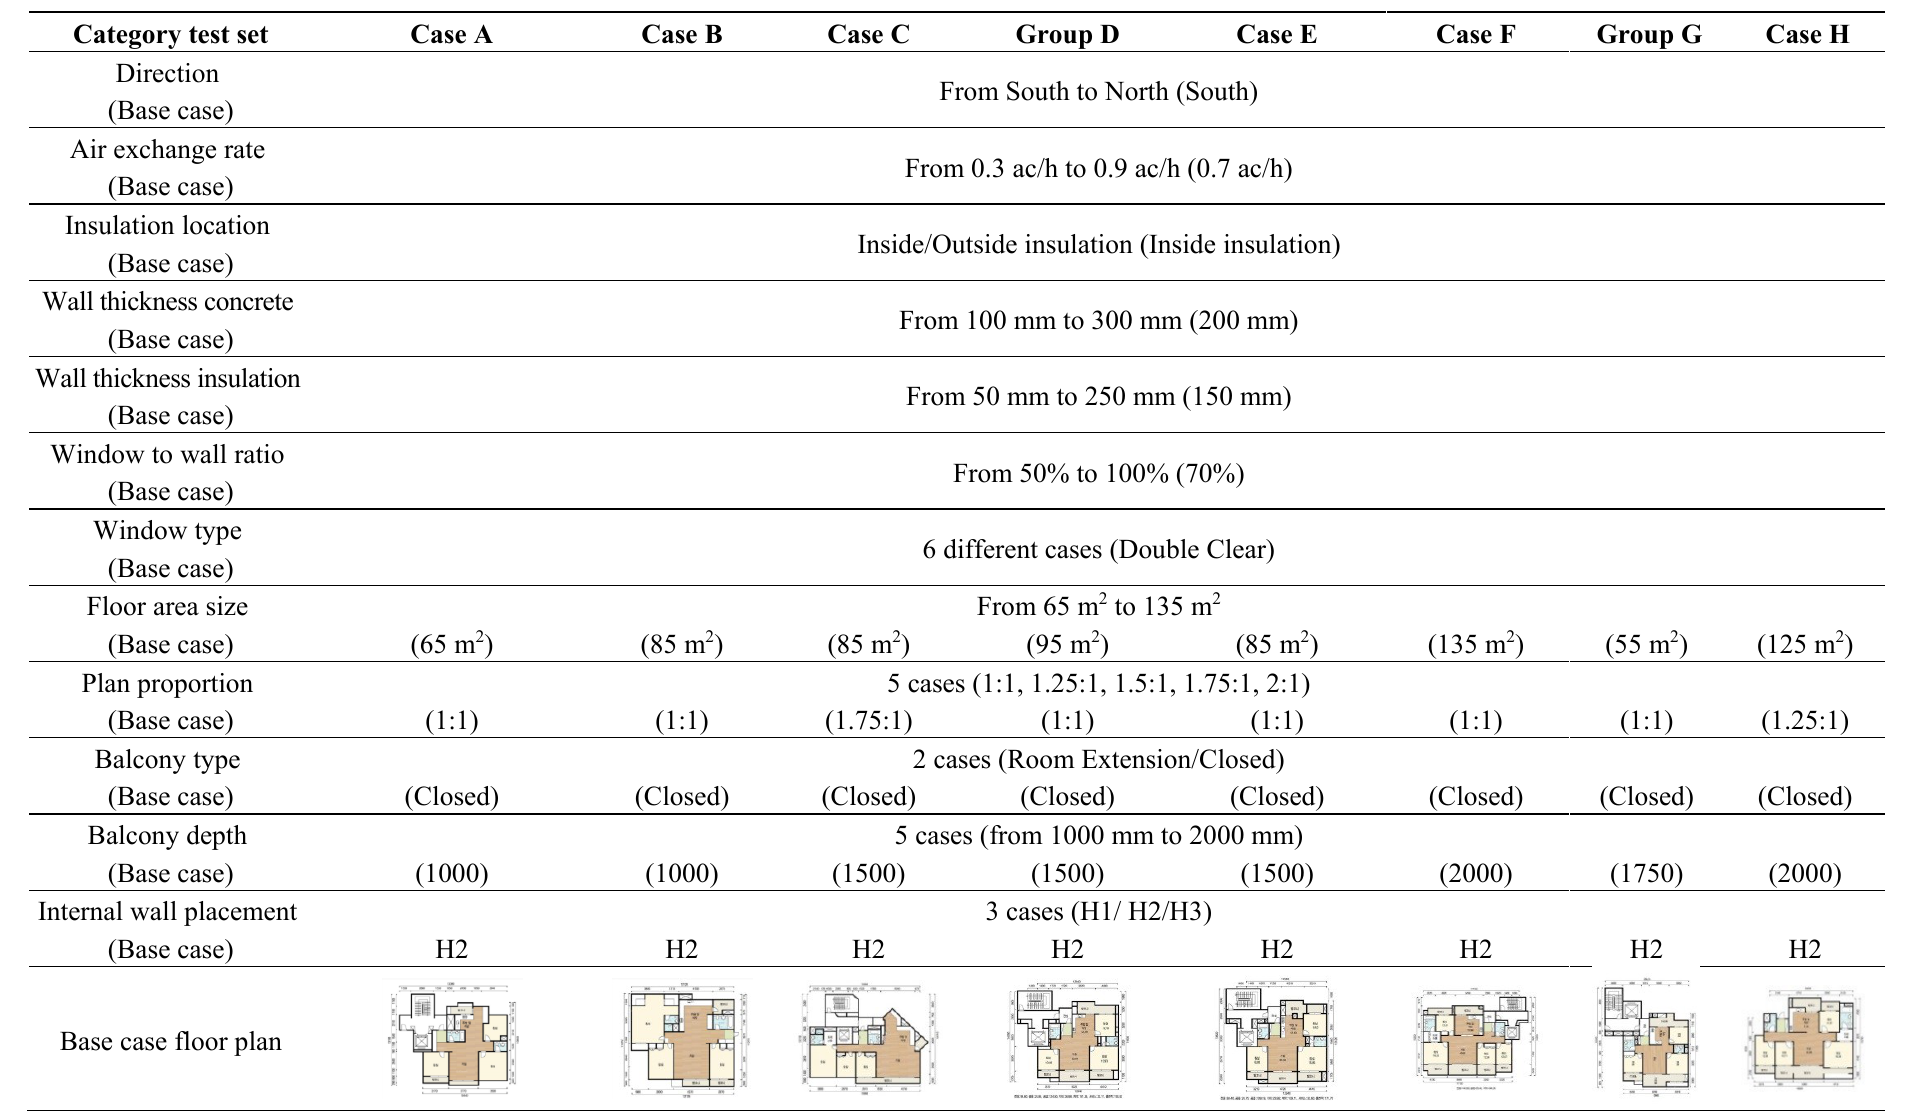
Table 12. The floor plan of a Korean apartment unit and input